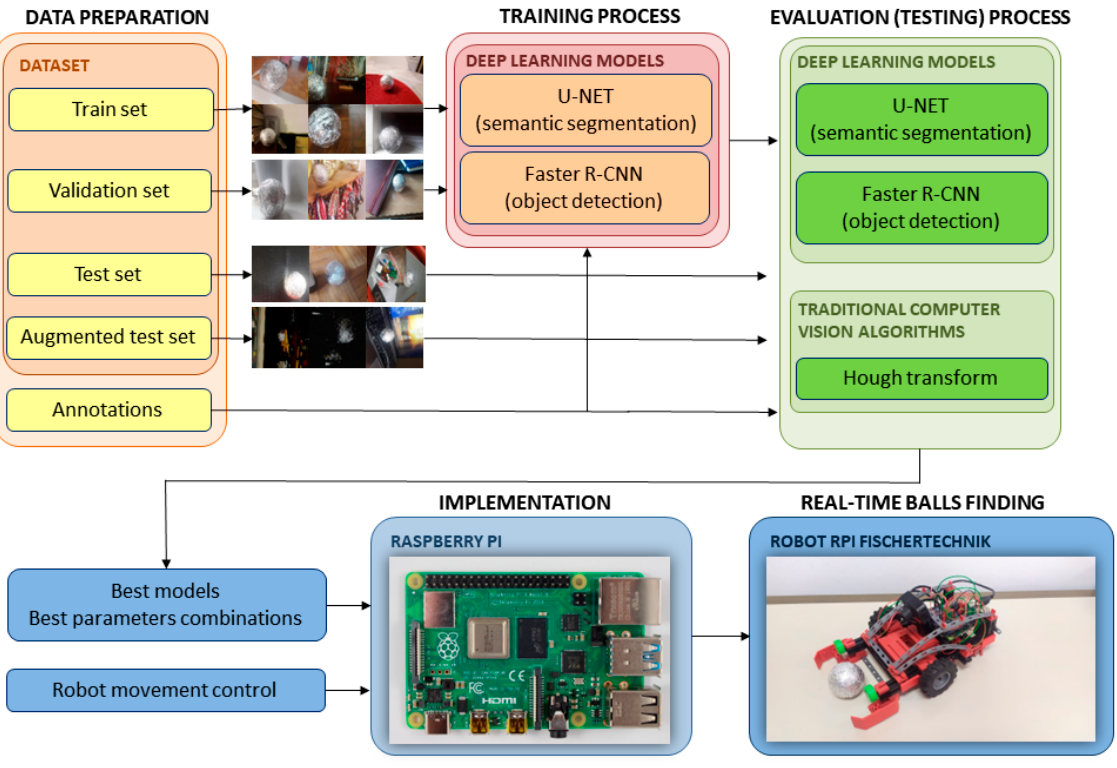
Figure 1. Model for real-time ball fi nding using educational robot.